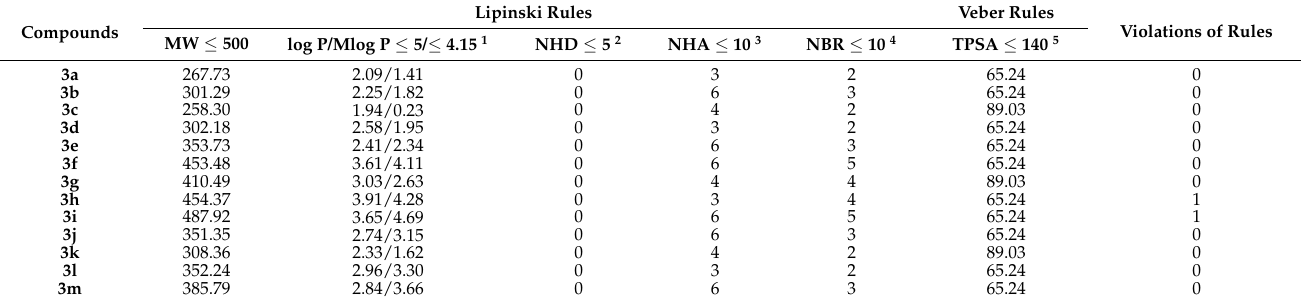
Table 2. Drug-likeness parameters of derivatives 3a-m according to Lipinski and Veber rules. Compounds